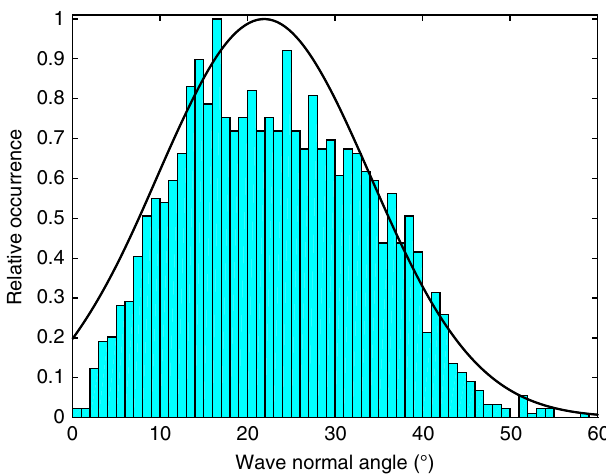
Fig. 2 Distribution of wave normal angle for Z-mode waves. These calculations assume a cold plasma index of refraction and are calculated only where density values are available for the data in Fig. 1. The index of refraction is based on the observed value of circular polarization, f pe and f ce . Calculations were done where the apparent circular polarization Stokes parameter, V , is >0.5; below this value the calculation is not reliable. The data is shown in blue as number of occurrences normalized to the maximum number of occurrences. The thick black line shows a Gaussian fi t to the data with a peak power at a wave normal angle of 21.88°, a width of